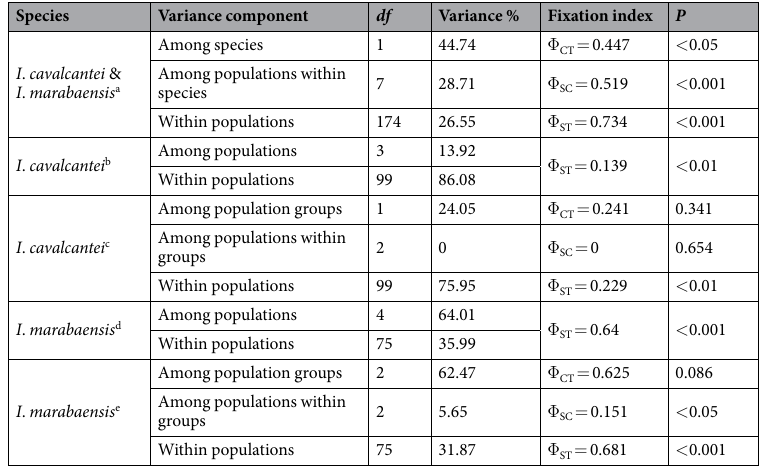
Table 2. AMOVA results, partitioning molecular variation of plastomes. a Canga groups (N1, N2, N3, N4), (N6, N7, N8, T, S11). b One group of Canga populations (N1, N2, N3, N4). c Canga populations groups (N1, N4),